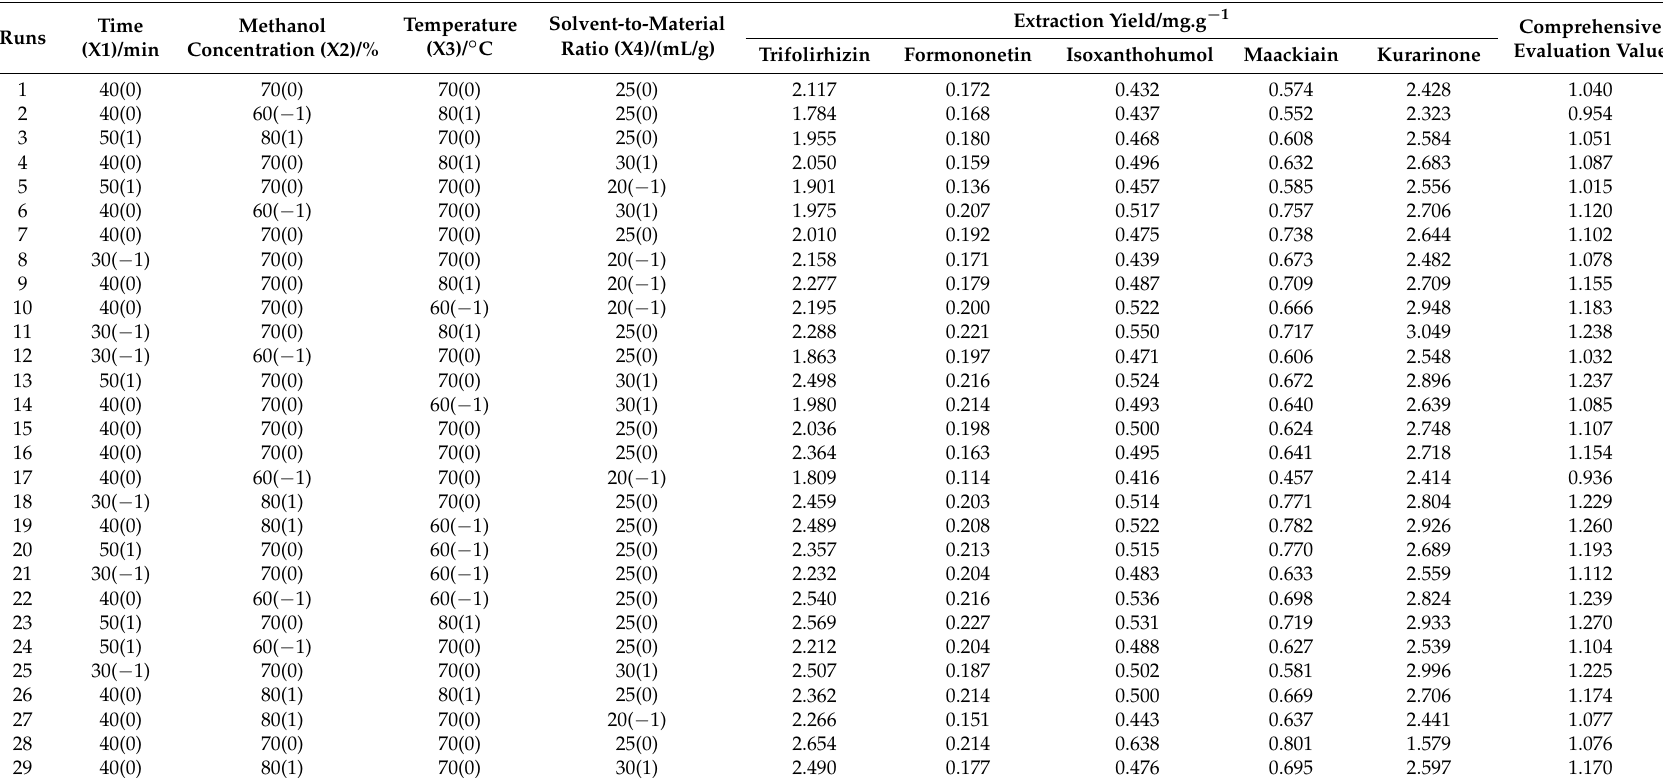
Table 3. Box–Behnken Design (BBD) for the independent variables and corresponding response